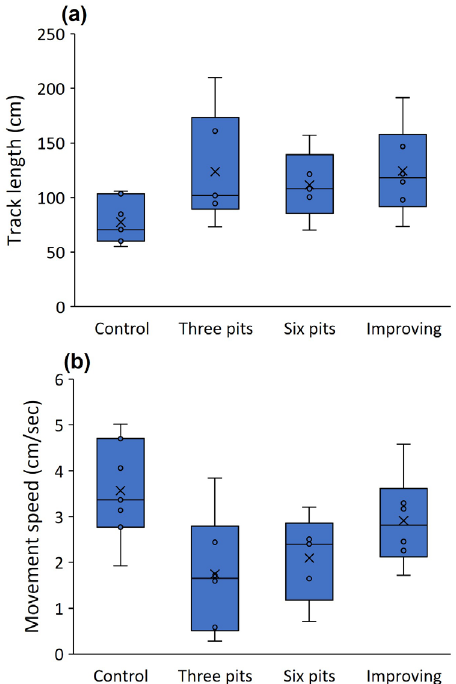
Figure 3. Track lengths ( a ) and movement speed ( b ) of the first worker arriving at the food reward in the three treatments of the first experiment (control, three pits, and six pits) and in the improving conditions (second experiment). Only the third run is presented. Lines and × signs in the box centers stand for the median and mean. Boxes and error bars stand for the quartiles and the range.